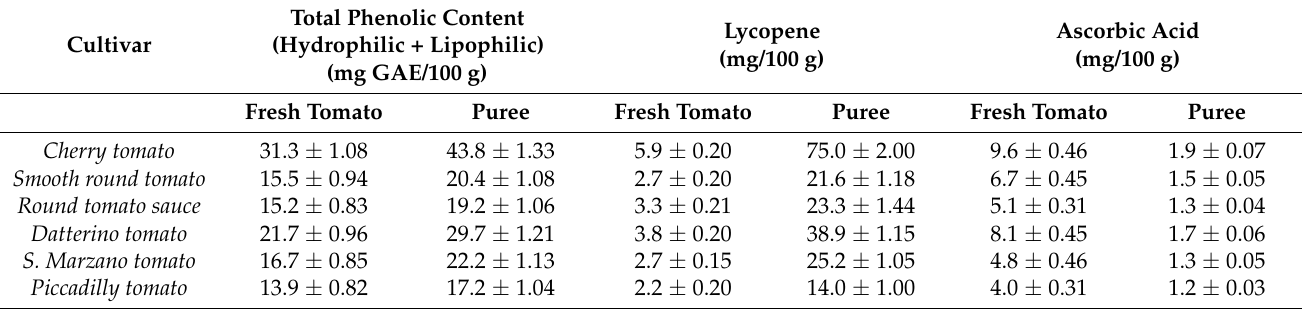
Table 4. Total phenolic content, lycopene, and ascorbic acid content in tomato purees.